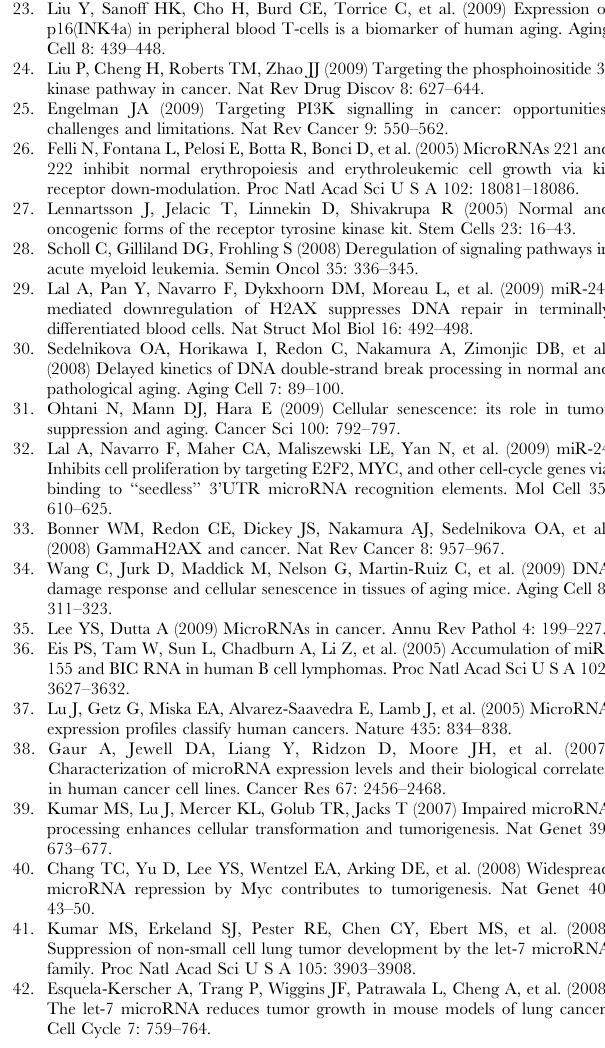
Table S4 Forward primer sequences for validated microRNAs. Found at: doi:10.1371/journal.pone.0010724.s004 (0.05 MB Figure S1 Real-time RT-PCR results for changes in miRNA expression in young and old participants. Expression of miRNAs from the miRNome analysis were further validated in 14 young and 14 old patient PBMCs (see Table 1B for detailed demographic data) using real-time RT-PCR as described in Materials and Methods. The histograms show normalized averages + SEM from duplicate experiments. ## P= 0.05 by Student’s t-test and P =0.04 by three-way ANOVA, # P= 0.08 by Student’s t-test. Found at: doi:10.1371/journal.pone.0010724.s005 (3.73 MB TIF)